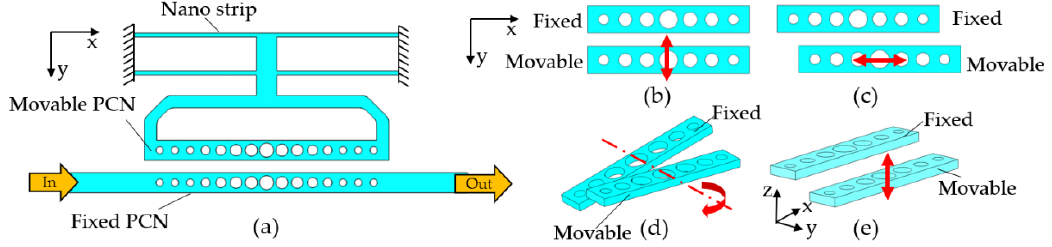
Figure 10. Schematics of mechanically tunable coupled PCN cavities: ( a ) doubly-coupled PCN cavity; ( b ) in-plane gap tuning [49–52] ; ( c ) in-plane lateral center offset tuning [53,54] ; ( d ) out-of-plane rotation [55] ; ( e ) out-of-plane bending [56] .